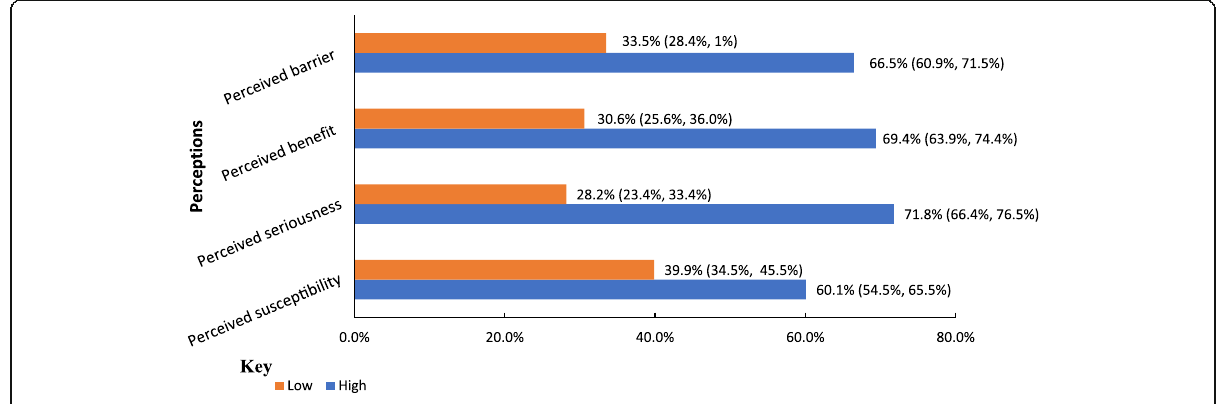
Fig. 1 Perceptions of COVID-19 and its vaccine among school teachers in Gondar city, Northwest Ethiopia (n = 301)